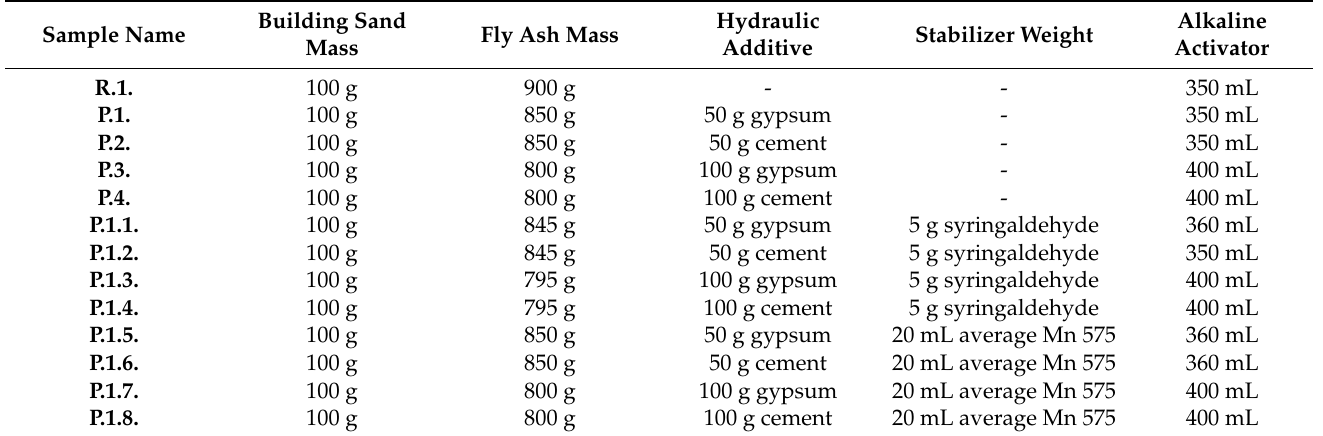
Table 3. Characterization of samples with hydrogen peroxide (30 mL) as foaming additive.